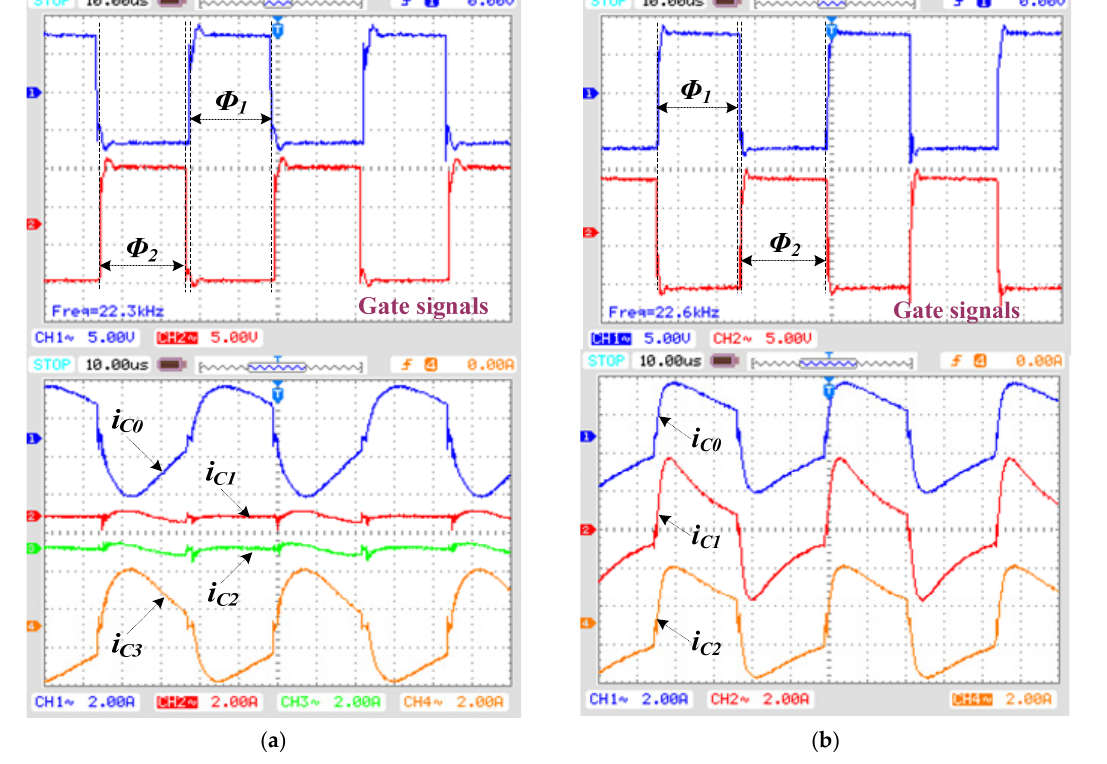
Figure 12. Gate signals and currents waveforms with ON switch S 3 _S 3 ’ : ( a ) waveforms of the proposed equalizer; and ( b ) waveforms of the conventional equalizer.